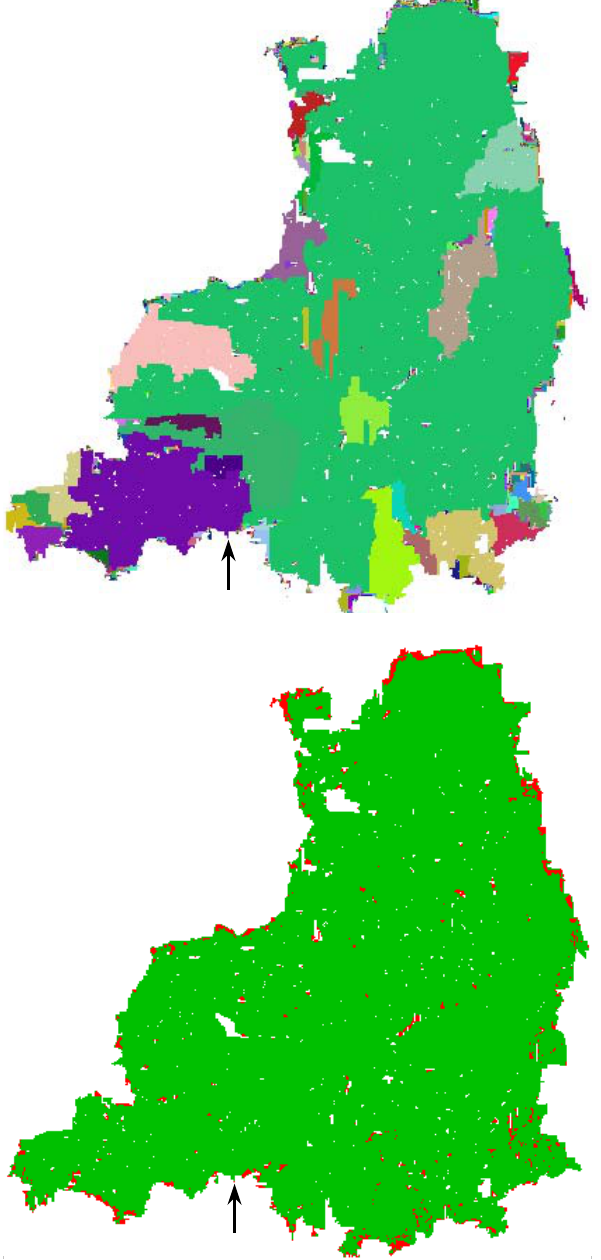
Fig. 6. Top: State of desynchronization of the first event from Fig. 5 at t = 3. Individual events are marked with random colors. Bottom: Respective hypocenters (red points). The arrow marks the hypocen- ter of the initial